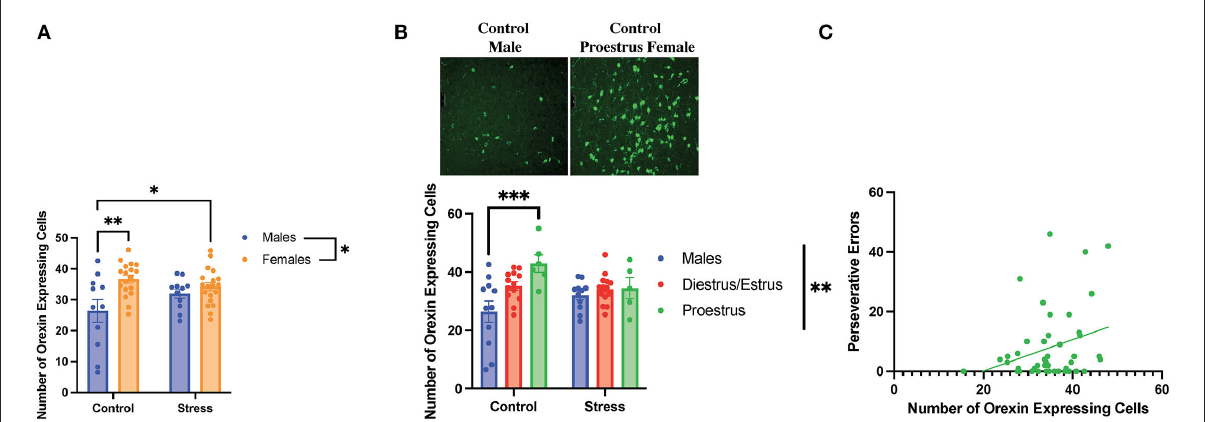
FIGURE9 Sex, gonadal hormone status, and stress affected the number of orexin-expressing cells. (A) There was a main effect of sex and an interaction between sex and stress on the number of orexin-expressing cells in the lateral hypothalamus. Specifically, the female rats in both the control and stress conditions had a higher number of orexin-expressing cells than the control male rats. (B) There was a main effect of gonadal hormone status and an interaction between gonadal hormone status and stress on the number of orexin-expressing cells. Interestingly, the proestrus female rats in the control group had more orexin-expressing cells than the male rats in the control group (representative image above of the number of orexin-expressing cells in the control male rats vs. the control proestrus female rats at Bregma level − 3.3mm). However, stress brought the male and female rats to comparable levels. (C) Number of orexin-expressing cells is positively correlated with perseverative errors in the light discrimination (LD) task. Two-way ANOVAs followed by Tukey post-hoc tests were conducted to examine the relationship between stress and sex or gonadal hormone status, and the interaction between the two variables on the number of orexin-expressing cells for the male rats. A correlation was performed to determine the relationship between the number of orexin-expressing cells and perseverative errors in the light discrimination task for the male ( n = 24, control = 12, and stress = 12) and female ( n = 40: control = 20, stress = 20; control diestrus/estrus = 14, control proestrus = 6, stress diestrus/estrus = 14, and stress proestrus = 6) rats. Error bars are plotted as mean ± SEM. * p < 0.05 , ** p < 0.01, and *** p <